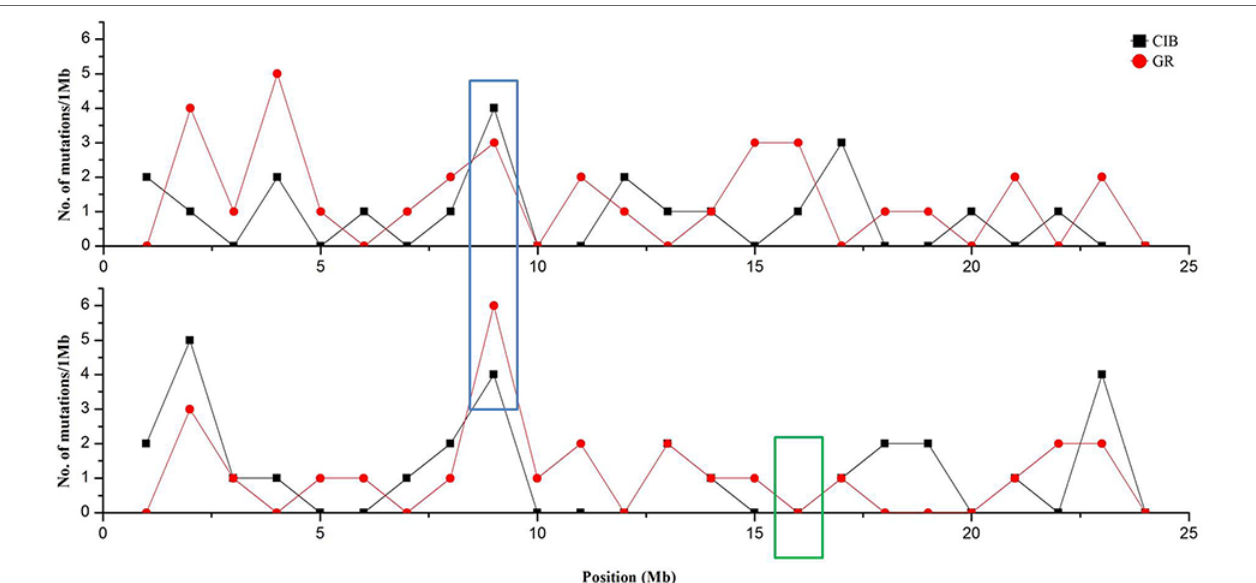
FIGURe 6 | Clustered mutation regions on Chr. 9 and Chr.10 (in blue box) and no mutation region on Chr. 10 (in green box). Red line and dots represent GR-induced mutations, and black line and squares represent CIB-induced mutations.